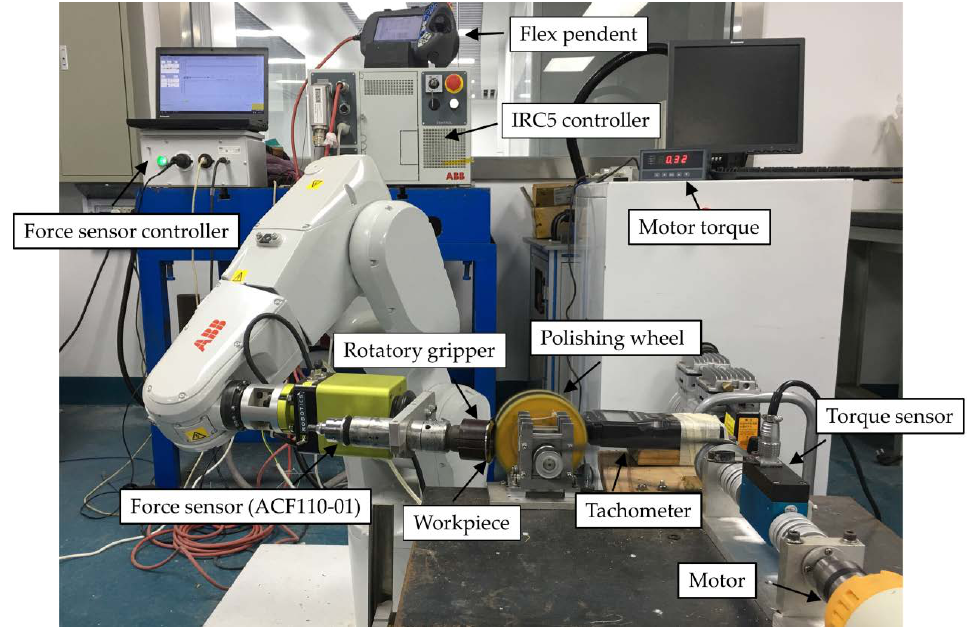
Figure 1. Proposed system setup for the robotic polishing.